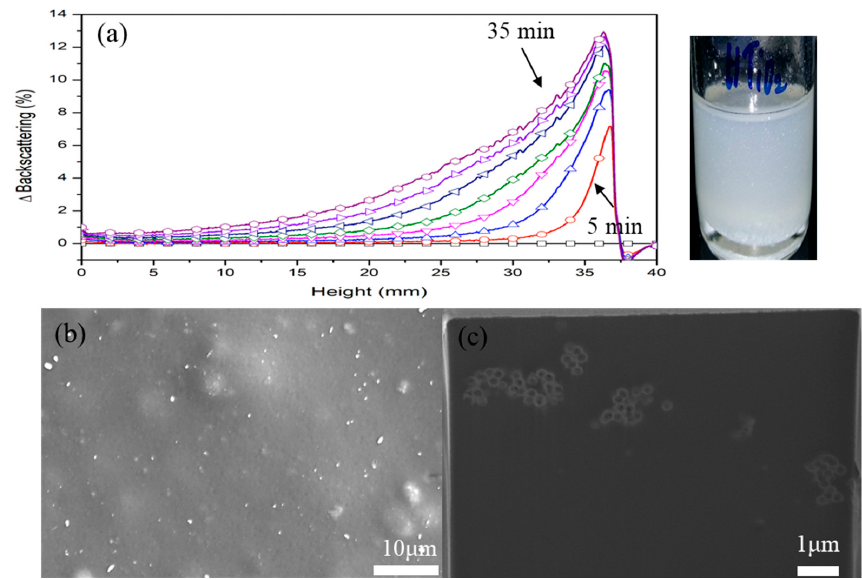
Figure 12. ( a ) BS profiles of titania aqueous solution (0.05 g/L) within 35 min; ( b ) top and ( c ) cross- sectional images of coating containing hollow titania.